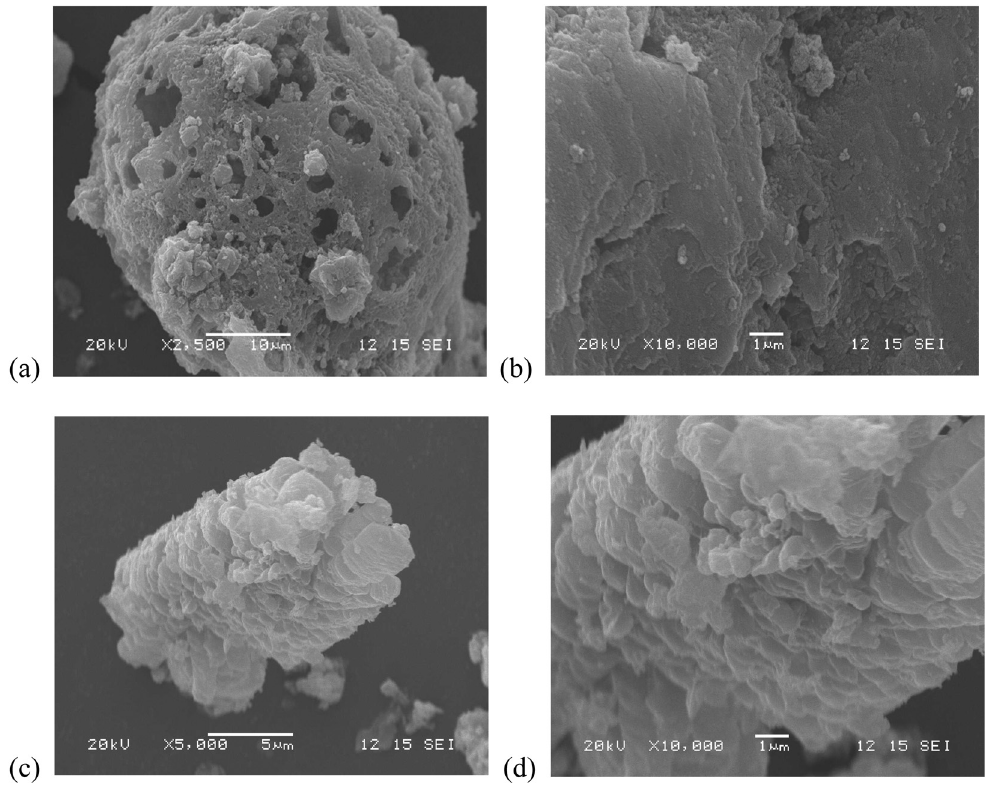
Figure 2: SEM photos of ( a and b ) fl y ash and ( c and d ) Na - P1 zeolite at di ff erent magni fi